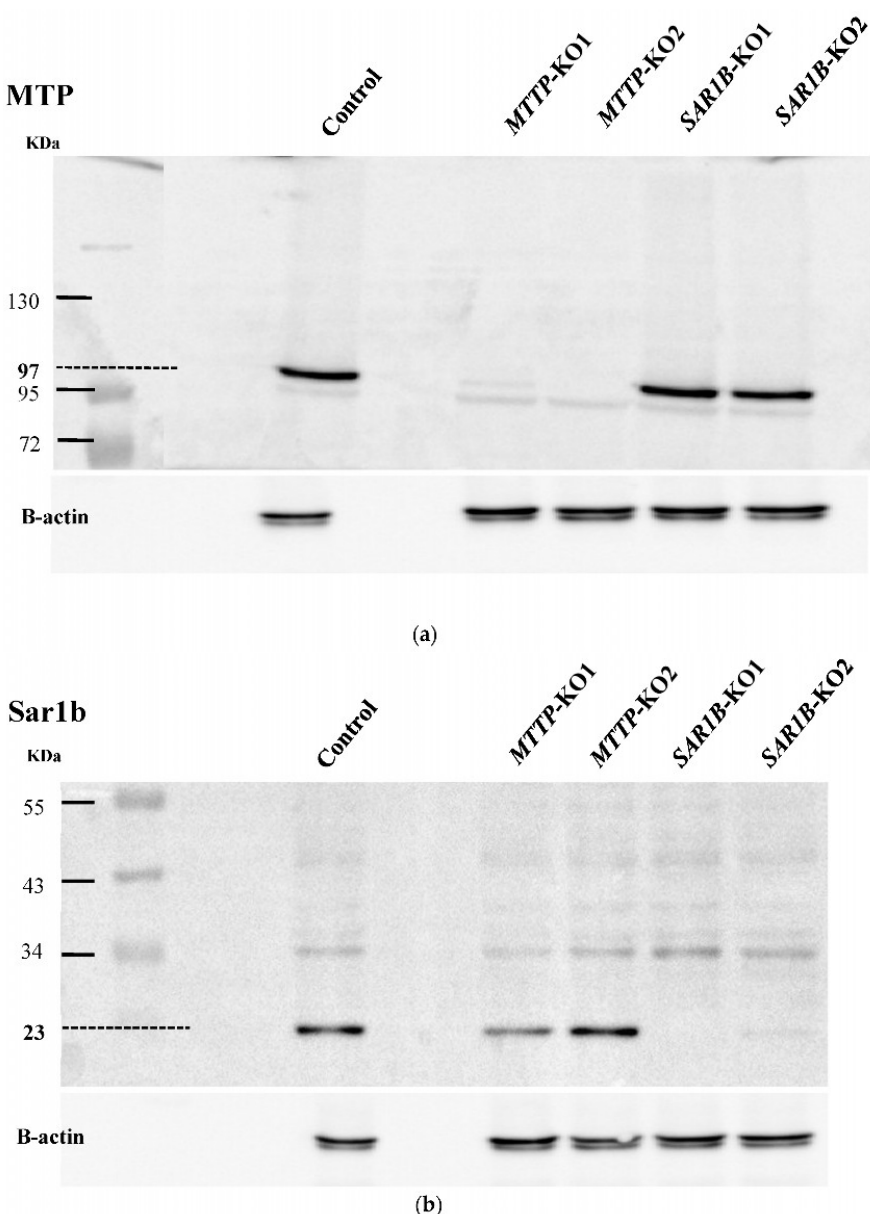
Figure 3. Knocking-out confirmation of MTTP or SAR1B by SDS-PAGE (4–10%) and Western blot analysis. Cells were cultured in T25 flasks for 21 days. Total protein was extracted from each transgenic clone and wild-type Caco-2/TC7 cells (WT), which were used as a positive control. Fifty µ g of extracts were resolved by 10% SDS/PAGE, and the blot was stained with monoclonal antibodies raised against MTP or Sar1b and β -actin to ensure equal lane loading. ( a ) Analysis of MTP levels in two clones transfected with MTTP -gRNA (first two bands) and two clones transfected with SAR1B -gRNA (last two bands), revealing no 97 kDa band for the two first clones while being detected in wild-type cells (positive control) and in clones transfected with SAR1B -gRNA, highlighting two clones without protein, named MTTP -KO1 and MTTP -KO2. ( b ) Analysis of Sar1b levels in 2 clones transfected with MTTP -gRNA (first two bands) and two clones transfected with SAR1B -gRNA (last two bands), revealing no 23 kDa band for the two last clones while being detected in wild-type cells (positive control) and in clones transfected with MTTP -gRNA, highlighting two clones without protein named SAR1B -KO1 and SAR1B -KO2.